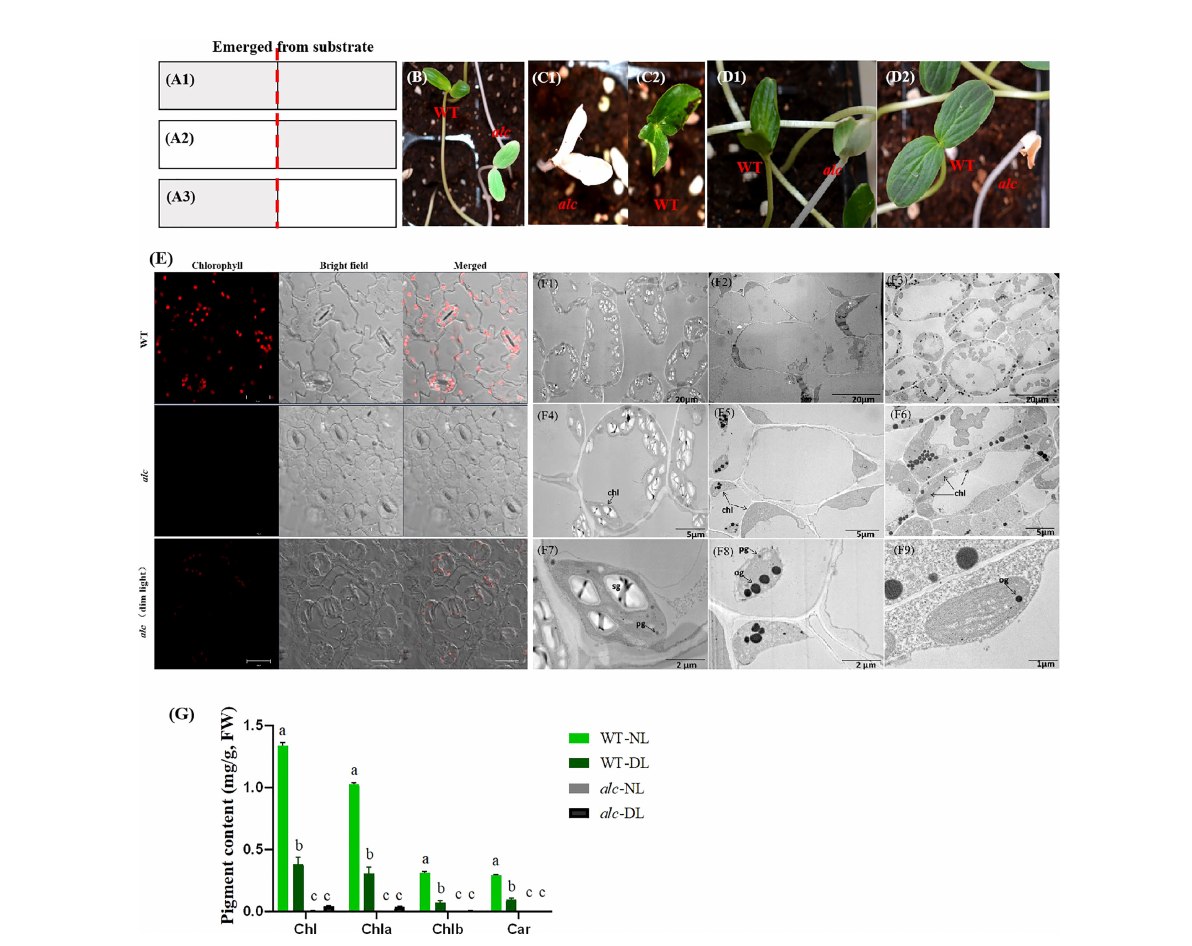
FIGURE 2 Short-lived chloroplast recovery in alc mutant under dim light condition. (A1 – A3) Schematic illustration of light treatments of WT and alc seedlings. A1 Plants were treated with continuous dim light before and after they emerged from substrate. A2 First, plants were treated with normal light irradiation, then after emerging from substrate, they were moved to dim light condition. A3 First, plants were treated under dim light, then after emerging from substrate, they were moved to normal light condition. (B) Phenotype of WT and alc seedlings under indicated condition that described in a1. (C) Phenotype of WT (C1) and alc (C2) seedlings under indicated conditions that described in A2. (D) Phenotype of WT and alc seedlings under indicated conditions that described in A3. D1 Phenotype of WT and alc seedlings exposed to normal light after 5 hours. D2 Phenotype of WT and alc seedlings exposed to normal light after 30 hours. (E) Fluorescence microscopy images of cotyledon abaxial epidermis of wild type, alc mutant cucumber seedlings grown under normal light condition and alc mutant seedlings grown under dim light condition. Bar: 20 m m. (F1 – F9) Transmission electron microscopy of cotyledons from alc mutant and wild type seedlings. F1, F4 An overview